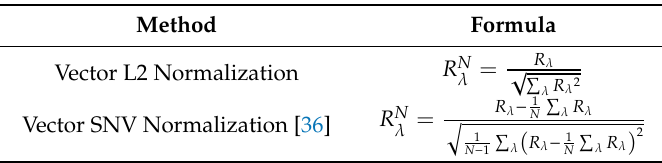
Figure 1. Overview of the workflow for field data of control (left) and grapevine leafroll-associated viruses (GLRaV-1) infected (right) vines. Depicted are a calibrated reflectance image at 800 nm coded as grey scale ( a , b ) and an RGB reconstruction (red-green-blue color space) ( c , d ), which is for visualization only. The hyperspectral image was segmented into leaves, grapes, stem material, and background ( e , f ) and detection models were applied on leaf pixels only ( g , h ). Vines were labeled with their GPS position and a 50 cm wide window was placed around each of them to avoid overlaps between plants. Based on a majority vote of pixel results per window the whole vine was classified as infected or healthy ( i , j ). Table 5. Pre-processing